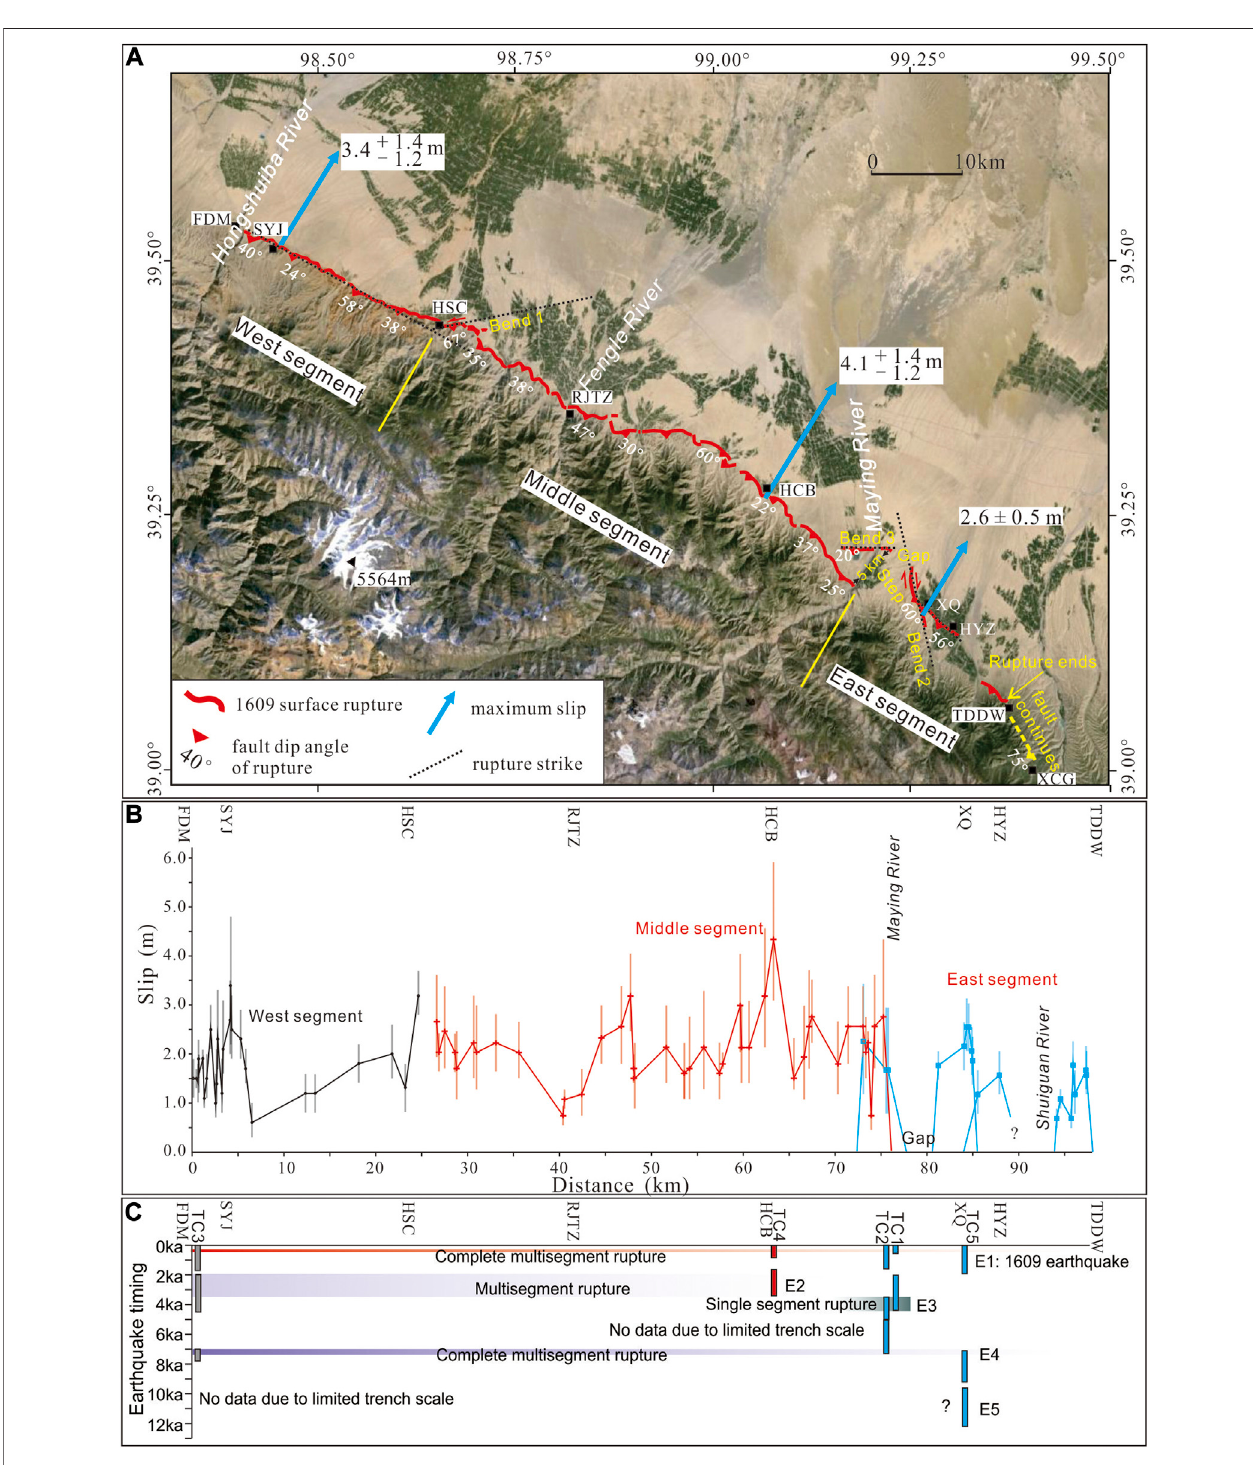
FIGURE 14 | Surface slip distribution of the 1609 earthquake and segmentation of surface rupture. (A) Surface rupture map and segmentation of the rupture. (B) Surface rupture slip distribution. (C) Possible correlation of the paleo-earthquakes along the Fodongmiao-Hongyazi Fault according the previous trenches work (Huang etal.,2018b).Placenames:FDM,Fodongmiao;SYJ,Shiyangjuan;HSC,HongshanVillage;RJTZ,Rujiataizi; HCB,Huangcaoba;XQ,Xiaoquan;HYZ,Hongyazi;TDDW, Toudaodongwan; XCG, Xichagou.